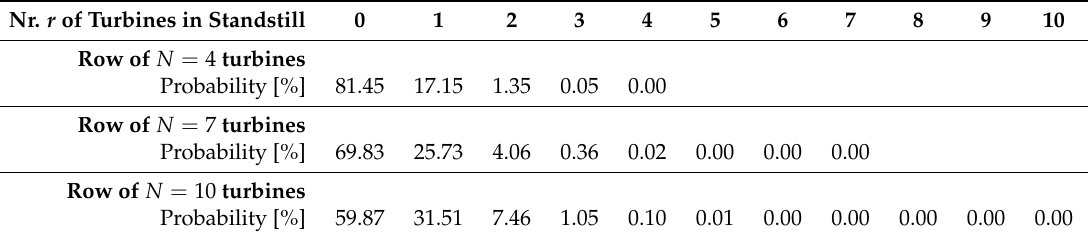
Table 1. Probabilities for standstill of a number of wind turbines within a row, based on standalone turbine availability of P avail =